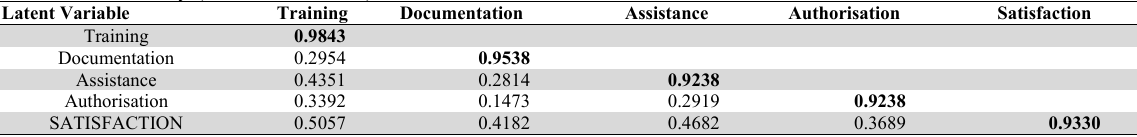
Discriminant validity (inter-correlations) of the reflective scales